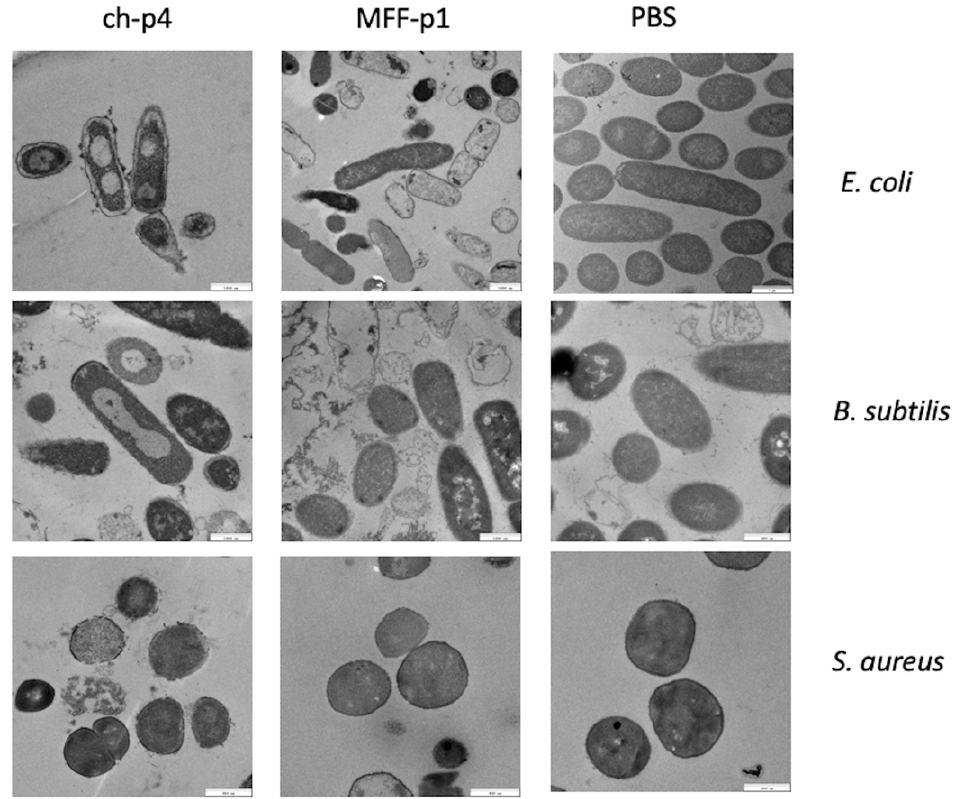
Figure 5. MFF-p1 disrupts the integrity of the superficial layers of bacteria. E. coli (HB101 strain) , B. subtilis (ATCC 9372 strain), and S. aureus (8325-4 strain) were incubated with chemerin-p4 (ch-p4) and MFF-p1 (100 µ M) peptides for 2 h. Bacteria morphology was assessed by transmission electron microscopy. The images in each panel are from one experiment and are representative of at least three independent experiments.